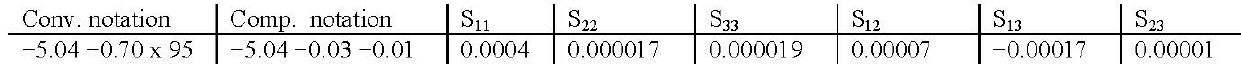
Table 1: Mean refractive state of the test eye given in conventional (sphere, cylinder and axis) and component notation ( I , J and K ). Included are the variances and